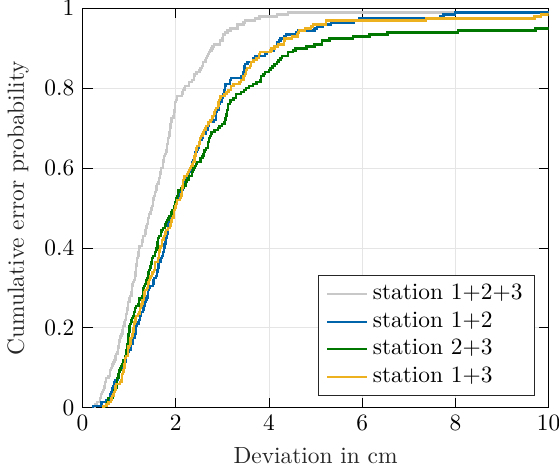
Figure 10. Overall localization results for the worst case of one station failing for a whole measurement